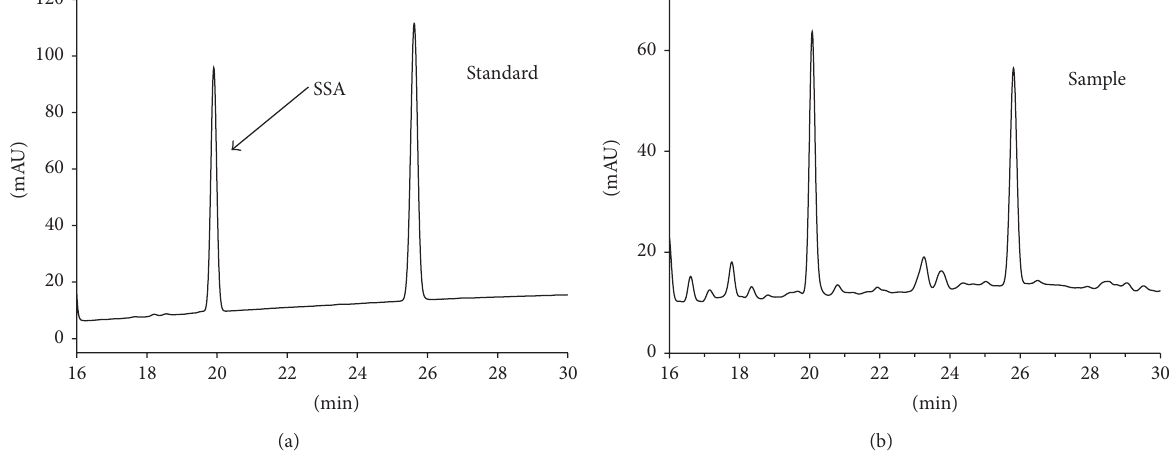
Figure 1: The chromatograms of Bupleurum chinense DC. extraction solution.